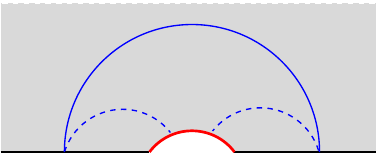
Figure 5 . Dual geometry to the thermofield double state of two BCFTs, showing two possible topologies for the RT surface for the region corresponding to the union of points in either CFT at a distance larger than x 0 from the